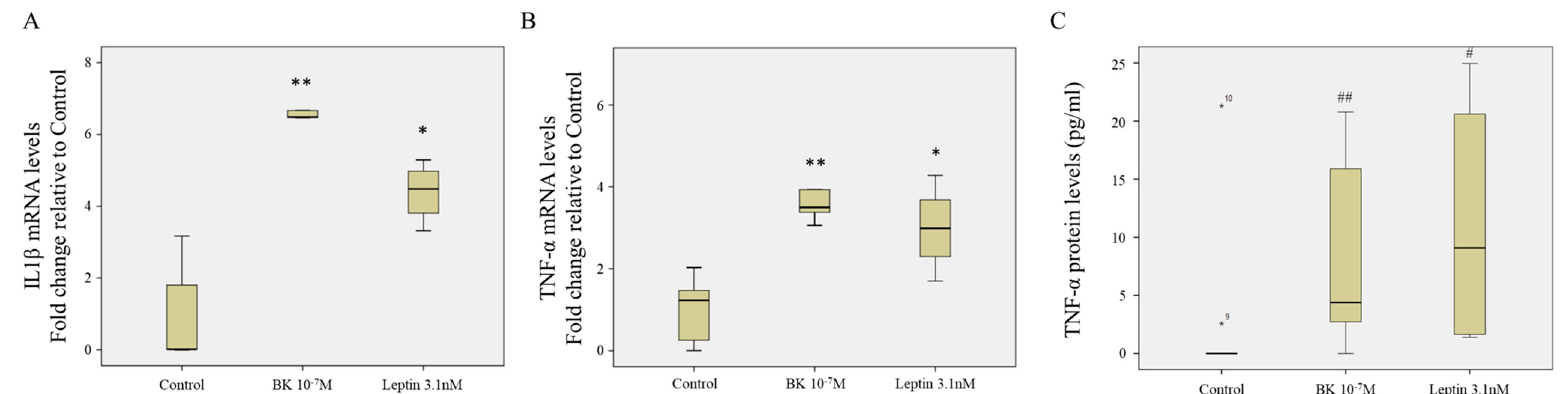
Figure 8. Assessment of the expression of IL-1 β and TNF- α . ( A ). mRNA level assessment of IL-1 β gene by RT-qPCR in response to BK and leptin 24 h relative to non-stimulated controls. Boxplots are representative of 5 different repeats. ** p < 0.01 BK vs. control and * p < 0.05 leptin vs. control. ( B ) . mRNA level assessment of TNF- α gene by RT-qPCR in response to BK and leptin 24 h relative to non-stimulated controls. Boxplots are representative of 5 different repeats. ** p < 0.01 BK vs. control and * p < 0.05 leptin vs. control. ( C ) . Protein level assessment of TNF- α protein (pg/mL) by ELISA in response to BK and leptin 24 h. Boxplots are representative of 11 repeats of control, 8 repeats of BK, and 4 repeats of leptin. The two asterisks (numbered 9 and 10) above the control average represent two outlier values for the levels of the TNF- α in the control samples as indicated by the conducted analysis. ## p = 0.008 of BK vs. control adjusted for multiple comparisons and # p = 0.013 of leptin vs. control adjusted for multiple comparisons.